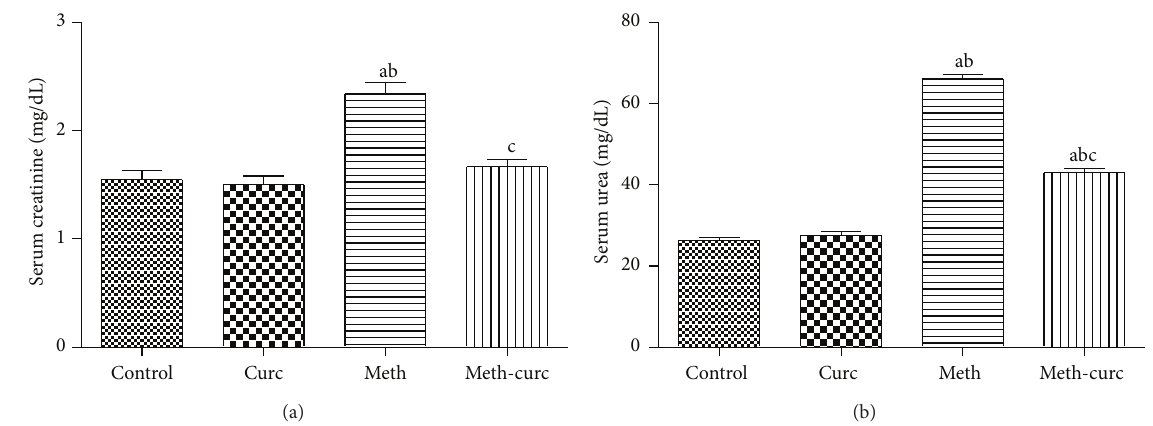
Figure 1: Effect of curcumin (Curc) on serum creatinine (a) and urea (b) levels of methotrexate- (Meth-) induced nephrotoxicity in rats. Data are mean ± SEM of 6–8 rats. a , b , c Significantly different from control, Curc, and Meth groups, respectively, at 𝑃 < 0.05 .